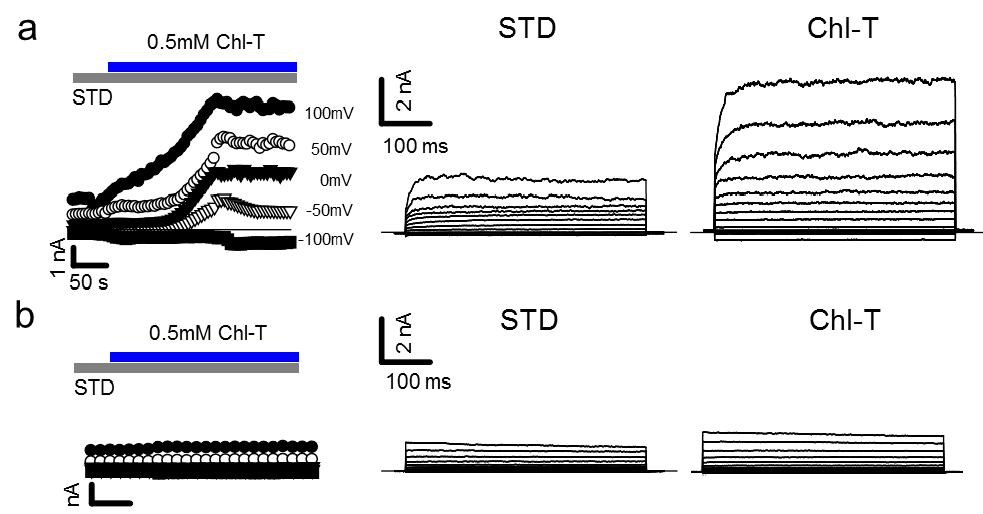
Table 1. Composition of the extracellular solutions (in mM; pH was 7.3).